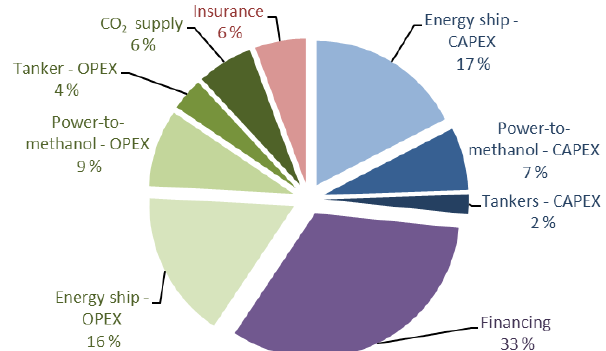
Figure 7. Cost breakdown of methanol produced by a first-of-a- kind FARWIND system. The shown data correspond to an average cost scenario (methanol cost equal to